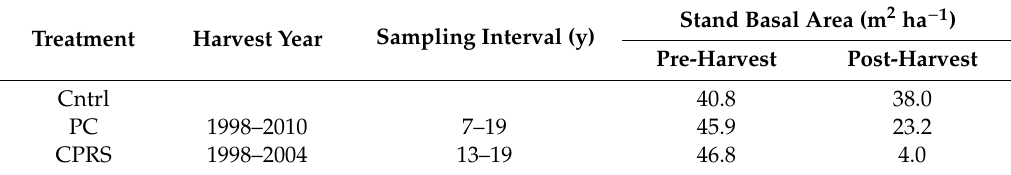
Table 1. Mean basal area (m 2 ha − 1 ) prior to and 7 to 19 years after treatment in 2017, in the boreal mixed-woods of eastern